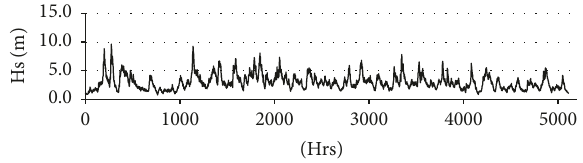
Figure 3: Plot of the September–April Hs time series of 03-04.